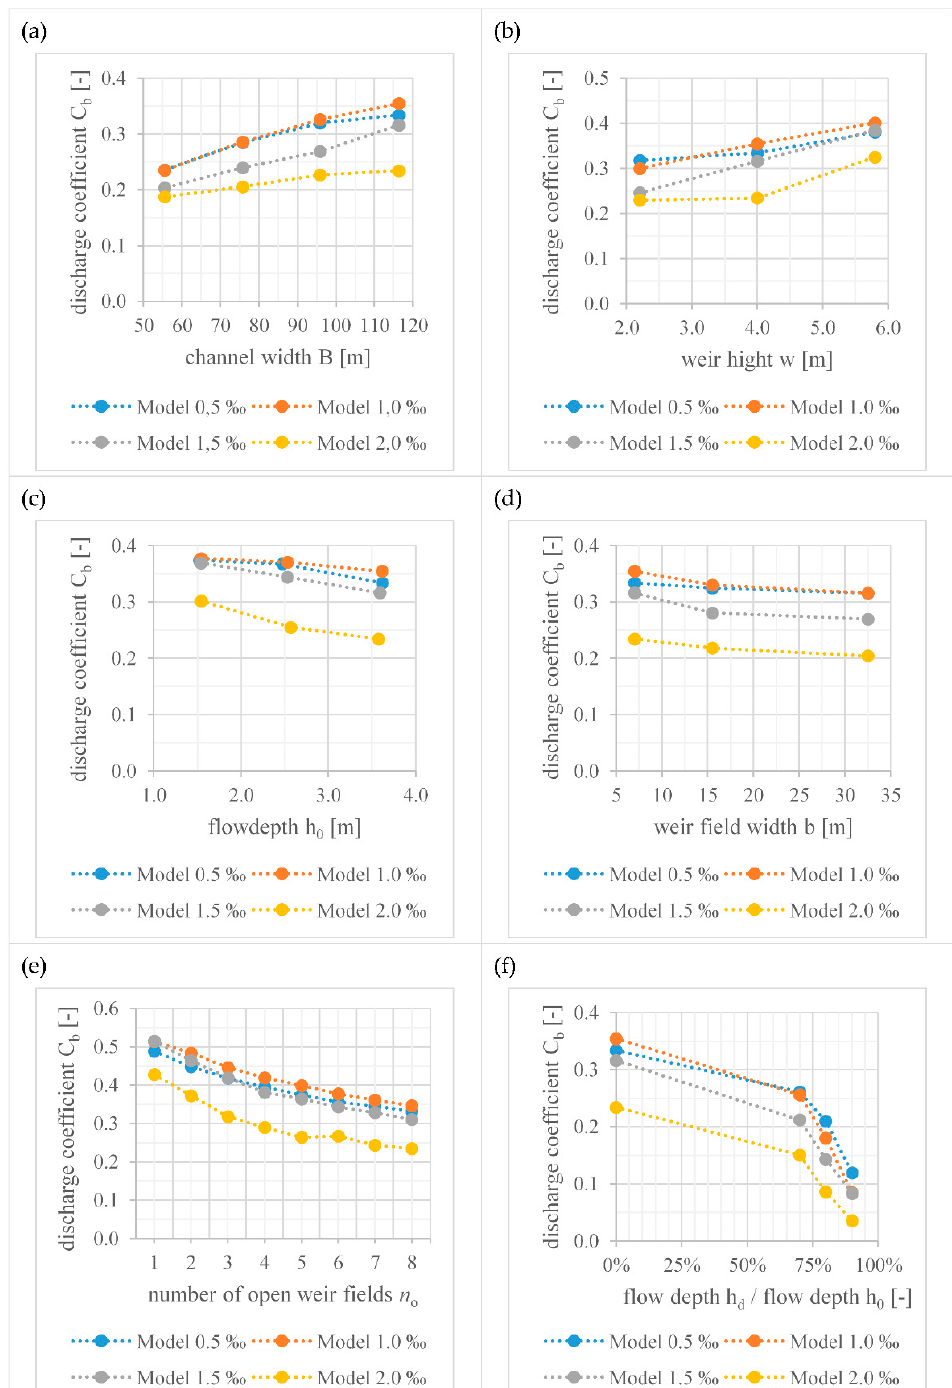
Figure 11. Influence of the analyzed weir and channel parameters on the discharge coefficient C b ; channel width B ( a ); weir height w ( b ); flow depth h 0 ( c ); weir field width b ( d ); number of open weir fields n o ( e ); ratio of underwater flow depth h d and flow depth h 0 at normal flow conditions closely upstream of the weir ( f ).